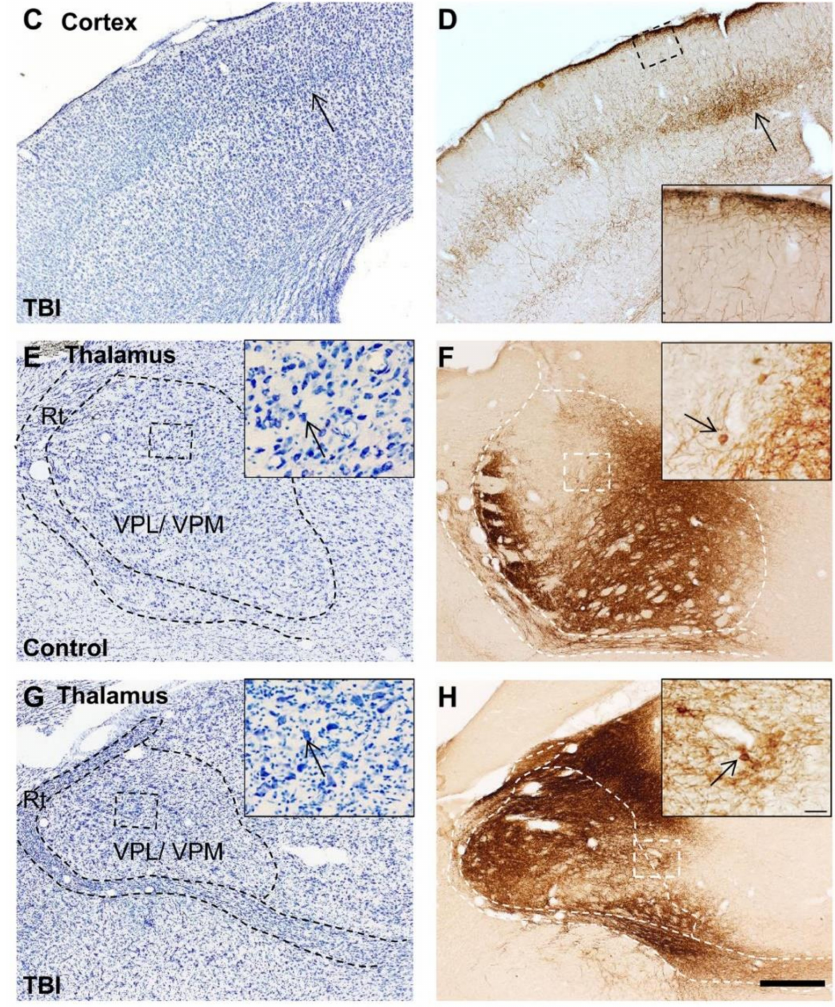
Figure 2. Brightfield photomicrographs of the cortex and thalamus of thionin-stained ( left panel ) and the adjacent immunostained eYFP-labeled ( right panel ) sections of a control and traumatic brain injured (TBI) rat. ( A ) A coronal section of the cortex of a control rat stained with thionin, ipsilateral to the viral injection. ( B ) The adjacent section of the control rat in ( A ) demonstrating eYFP-immunoreactivity (ir) (ChR2-eYFP expression) in the cortex. A dense plexus of ChR2-eYFP- expressing varicose fibers (axons) innervates cellular clusters in layers IV and V (open arrow). Note that immunopositive axons send collaterals into layer I (see insert). ( C ) A thionin-stained coronal section of the perilesional cortex from a rat with TBI. Note the similar group of cells as in the control rat (open arrow). ( D ) An adjacent section of the TBI rat in panel C, demonstrating ChR2-eYFP- expressing varicose fibers in the cortex. Note the decreased axonal density and less clear columnar organization of immunopositive terminals in layers IV and V. Also, the density of immunopositive terminals in layers II and III was lighter and the terminal plexus was more scattered in the TBI rat (insert). ( E ) A thionin-stained section showing the ipsilateral thalamus of a sham-operated experimental control rat. There was no cell loss in the ventral posterolateral (VPL) and ventral posteromedial (VPM) thalamic nuclei (see insert). ( F ) ChR2-eYFP expression in the thalamus from the section adjacent to panel E. Note the expression of ChR2-eYFP in the cells of the VPL and VPM nuclei (insert). ( G ) A thionin-stained section of the ipsilateral thalamus of a TBI rat. Note the atrophy and neurodegeneration in the VPL and VPM thalamic nuclei. The remaining neurons of the VPL and VPM express ChR2-eYFP (insert). ( H ) The adjacent section to panel G, showing ChR2-eYFP expression in the VPL and VPM thalamic nuclei. Note the neuronal expression of ChR2-eYFP (insert). Scale bar in A–H equals 400 µ m and in the insert equals 40 µ m. Abbreviation: Rt, reticular